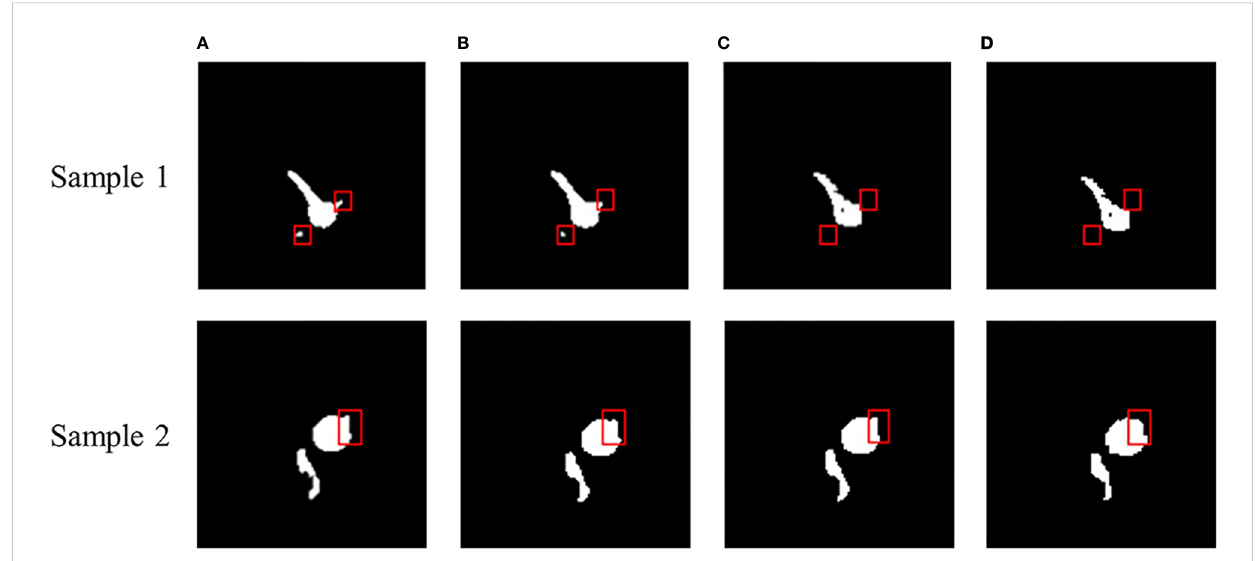
FIGURE 4 Sample segmentation effect of MRI images. (A) Real label, (B) MRSwinUNet, (C) TransUNet-D, (D) SwinUNet-D.